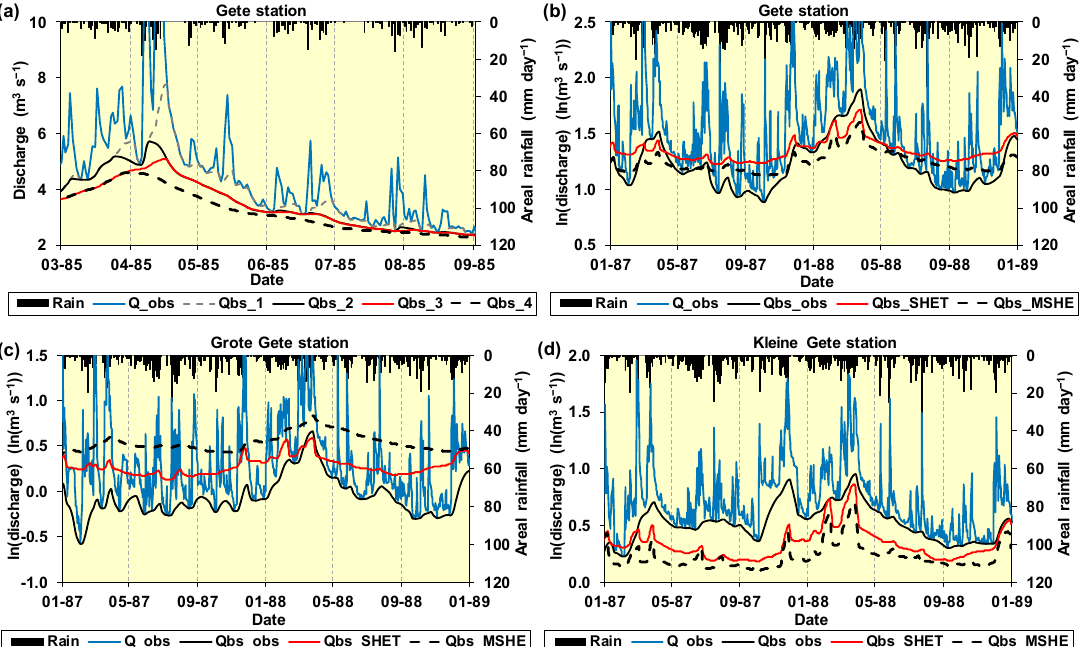
Figure 10. Flow component hydrographs showing the filtered baseflow (Q bs ) estimates for ( a ) the observed hydrograph at the outlet of the study catchment for some months of the year 1985 (plotted Q bs hydrographs correspond to passes 1 to 4, namely, Q bs_1 , Q bs_2 , Q bs_3 and Q bs_4 ); and for ( b – d ) the hydrographs simulated by both SHETRAN (Q bs_SHET ) and MIKE SHE (Q bs_MSHE ) for the three study river stations in the validation period [1 January 1987–31 December 1988] (Q bs was estimated using 3 passes). The observed total hydrograph (Q_ obs ) as well as the respective estimated baseflow (Q bs _ obs , after 3 passes) are plotted in ( b – d ) for comparison